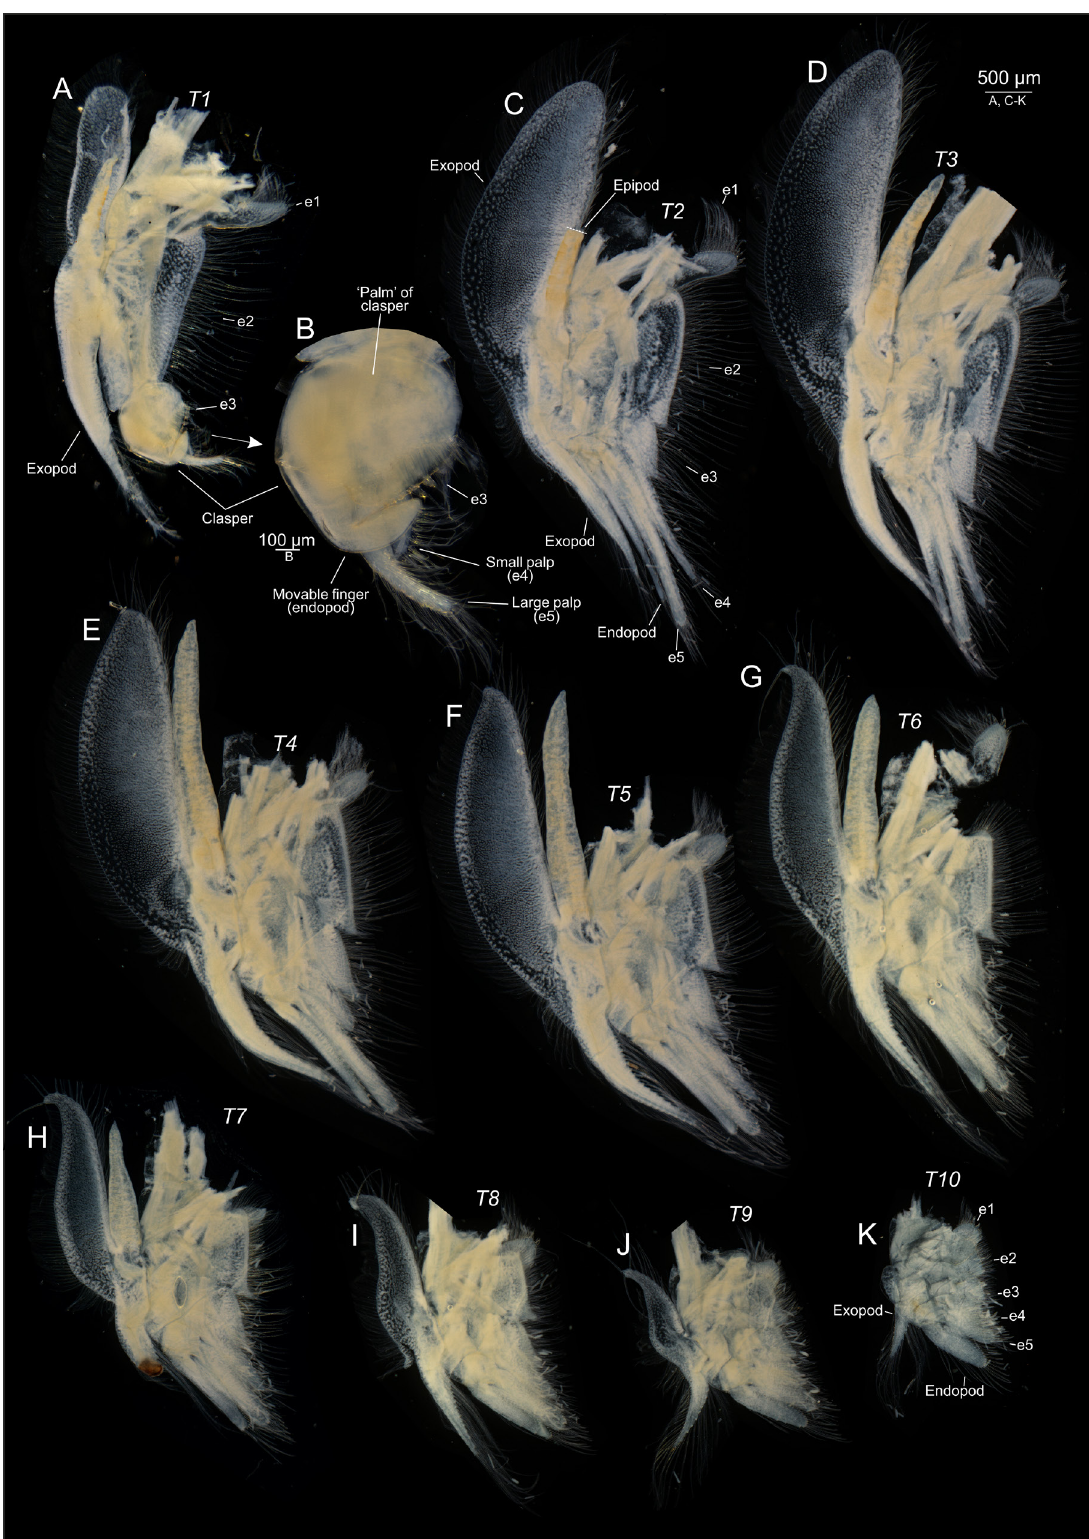
Fig. 6. Lynceus insularis sp. nov., ♂, light microscopy (holotype, ZMUC-CRU-4783), thoracopods of right side seen from anterior. A . Thoracopod 1 (clasper limb). B . Clasper of thoracopod 1. C–K . Thoracopods 2–10. Abbreviations: e1–e5 = endites